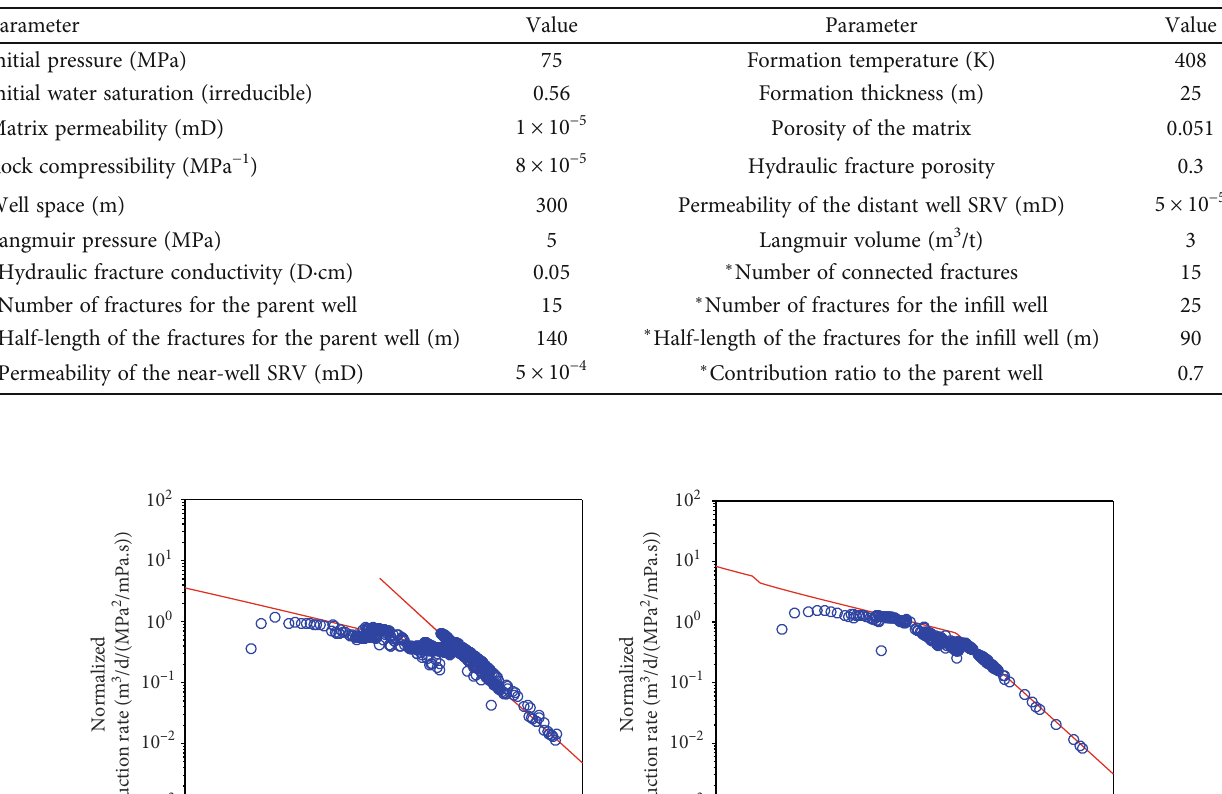
Figure 11: The production performance of the parent and in fi ll wells for the fi eld case. Table 5: The formation properties and fi tted parameters using the semianalytical model.